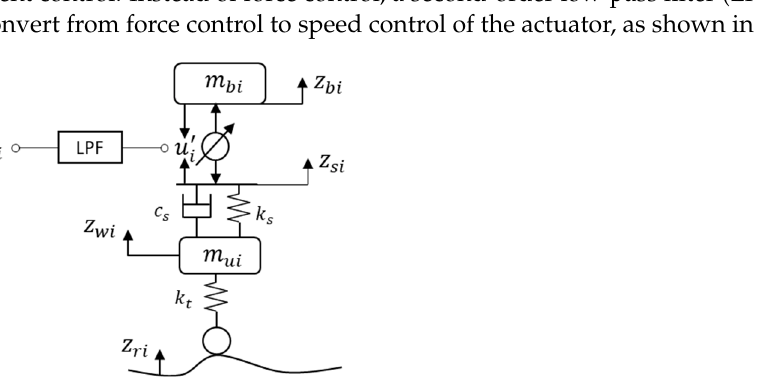
Figure 3. A series active suspension with a second-order low-pass filter.